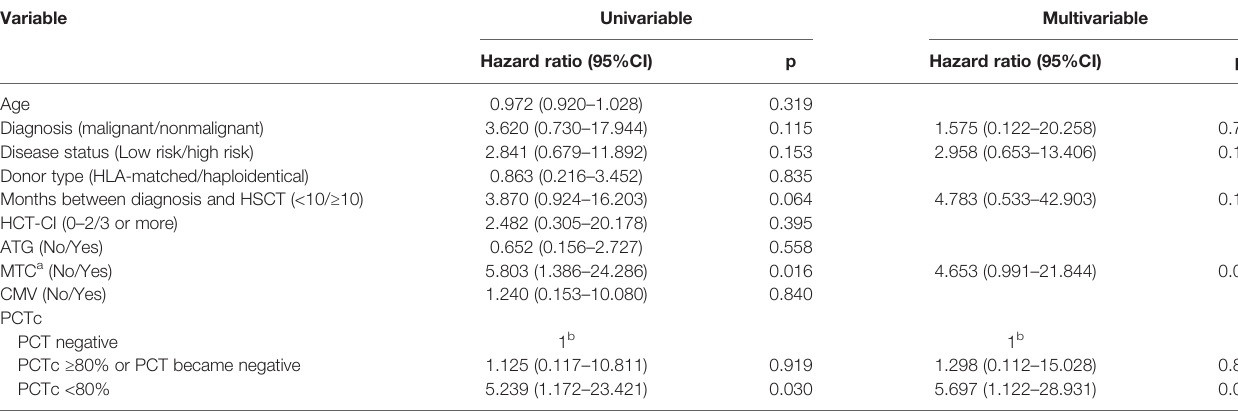
TABLE 2 | Univariable and multivariable analysis for 100-day survival of the primary cohort.